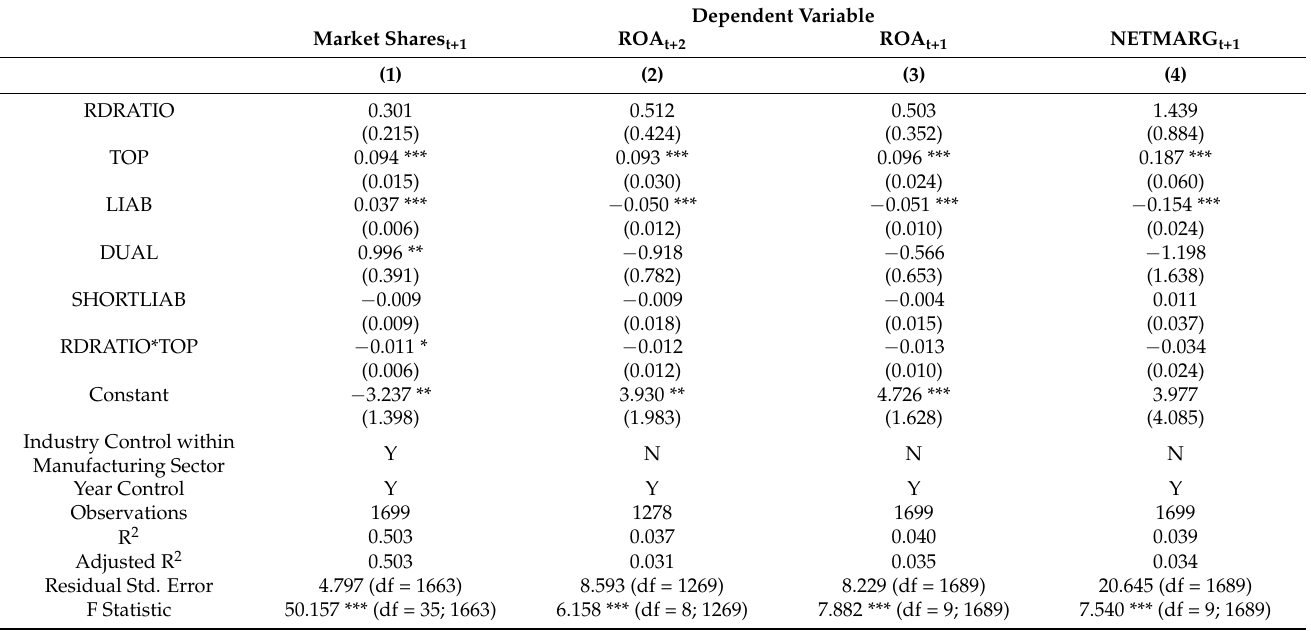
Table 8. State-owned